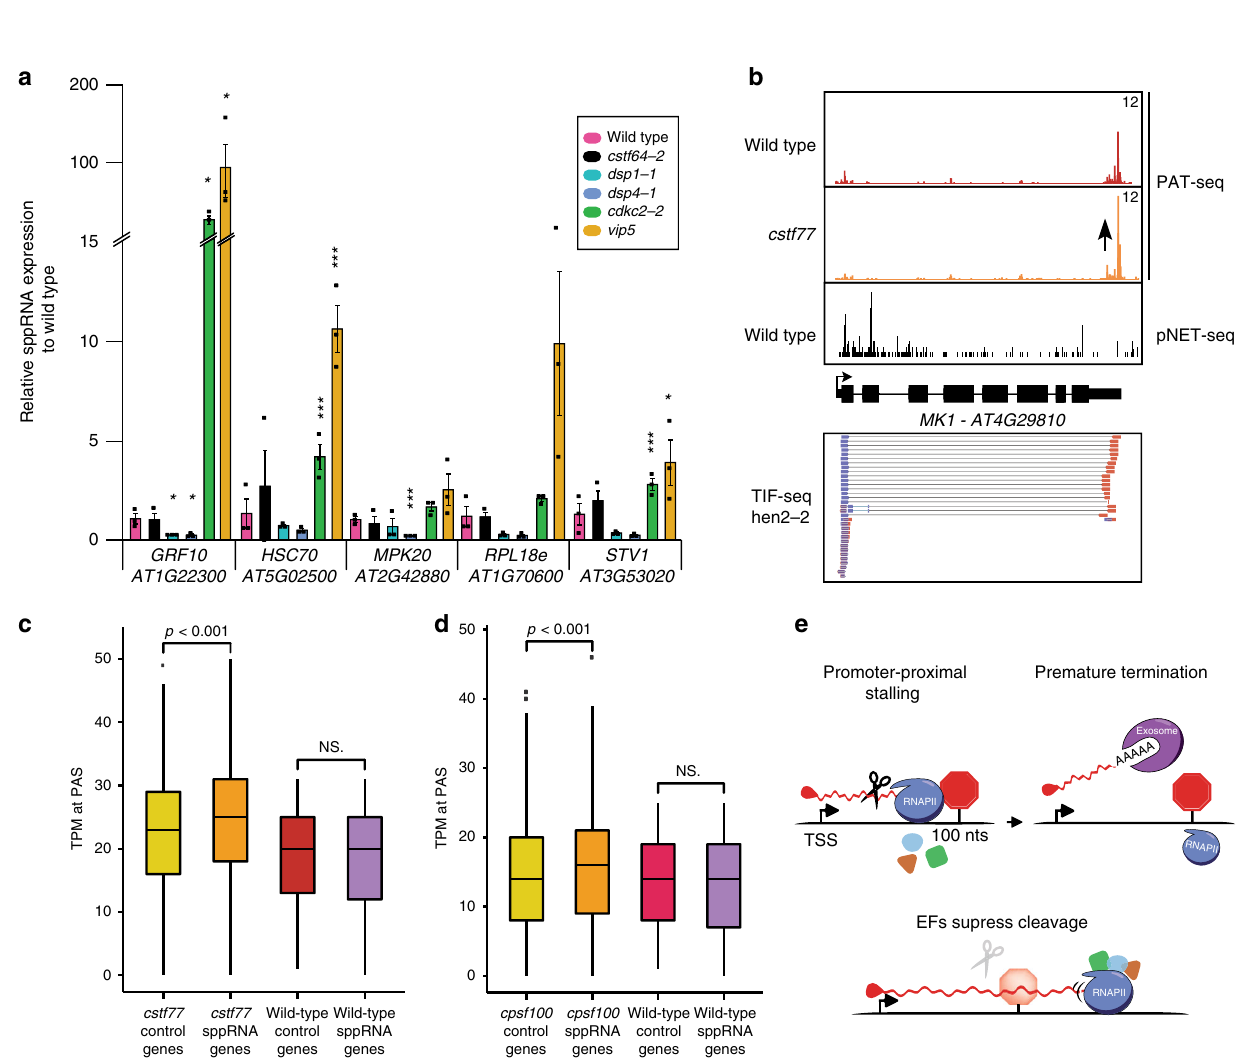
Fig. 6 RNAPII elongation and termination shape transcript isoforms. a RT-qPCR analyses of sppRNA for fi ve genes with sppRNAs in wild type, cdkc2-2 , vip5 , dsp1-1,dsp4-1 and cstf64-2 . Data are presented as mean values ± SEM from three independent experiments. Black circles indicate individual data points ( n = 3). Single asterisk denotes p < 0.05, two asterisks denote p < 0.01, whereas three asterisks denote p < 0.001 between mutant and wild type by two- sided Student ’ s t -test. b Genome browser screenshot of the MK1 gene. Visualisation of PAT-seq data for wild type (red) and cstf77 (orange), pNET-seq data (black) and hen2-2 TIF-seq data. Black arrow represents the increase of PAT-Seq signal in cstf77 . c Distribution of TPM at mRNA PAS for sppRNA genes ( n = 1173) and its speci fi c control set of genes ( n = 1170) (Methods) in wild type and cstf77 mutant. d Distribution of TPM at mRNA PAS for sppRNA genes ( n = 1161) and its speci fi c control set of genes ( n = 1129) (Method) in wild type and cpsf100 mutant. In c and d , p < 0.001 denote the p -value calculated by two-sided Wilcoxon test between mRNA PAS usage for sppRNA genes compared to a set of control genes displaying equal distribution of nascent gene body transcription in the mutants, NS denotes no statistically signi fi cant difference. In c and d , the box bounds the iQR divided by the median, and whiskers extend to a maximum of 1.5× iQR beyond the box. e Schematic representation of promoter-proximal RNAPII stalling ~100 nt downstream of TSSs coinciding with nascent transcript cleavage, polyadenylation, and exosome-mediated degradation of sppRNAs. Elongation factors (EF) suppress promoter-proximal termination. Source data of a are provided in the Source Data fi